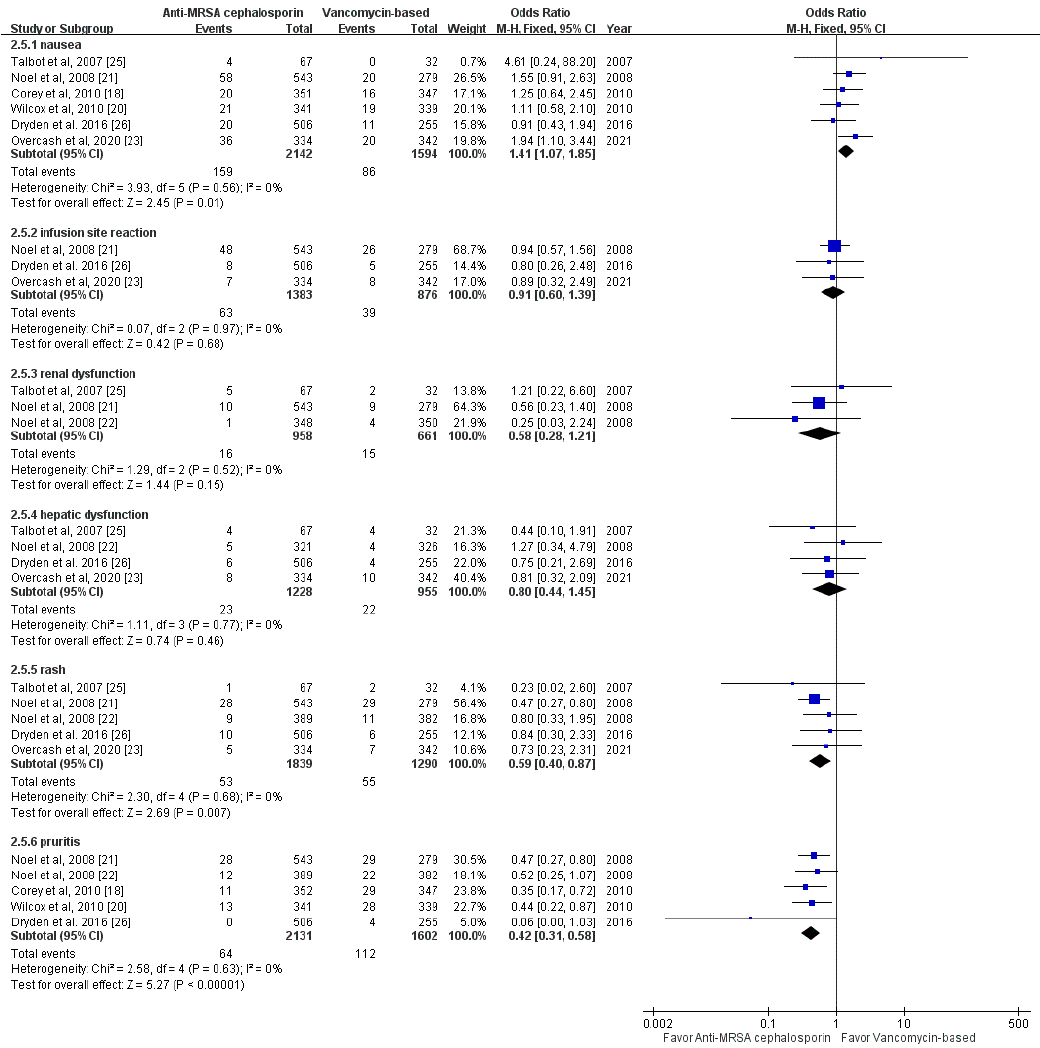
Figure 4. Forest plot of the comparison of the risk of specific adverse events between anti-MRSA cephalosporin-based and vancomycin-based treatments.